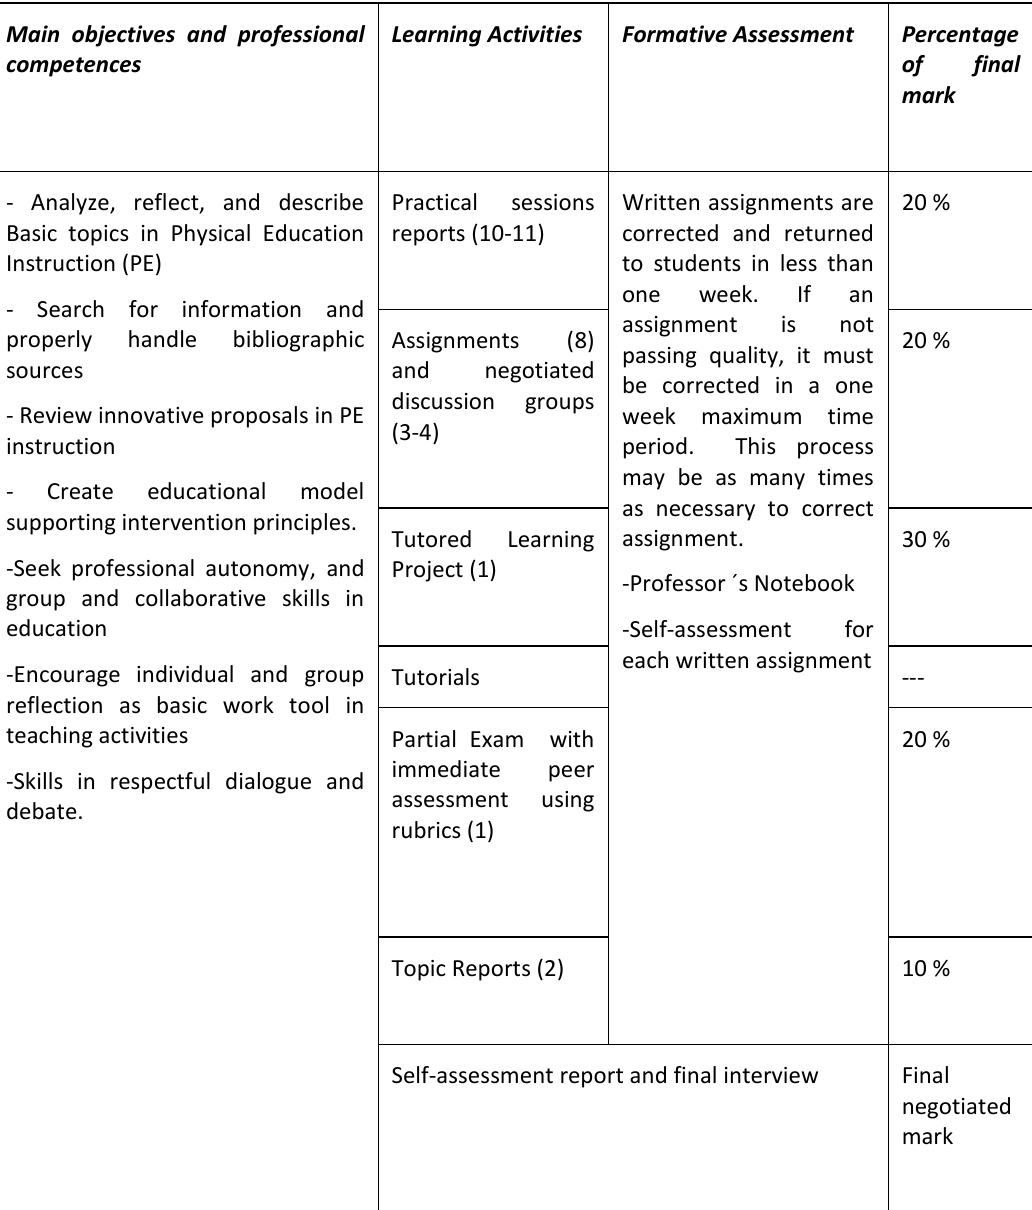
Table 2: Relationship between different course curriculum elements: Objectives, learning activities, formative assessment, and